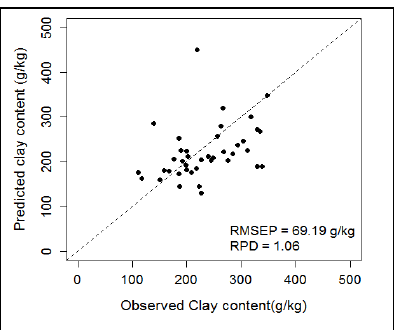
Figure 5: Predicted clay content versus observed clay content, using soil spectra .